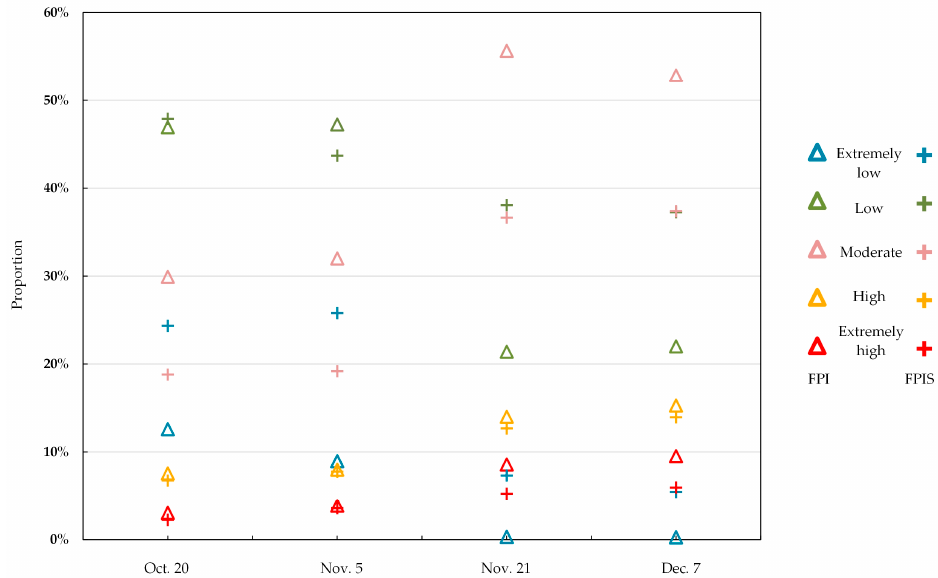
Figure 6. The dynamic changes of forest fire risk in Zhaoqing, based on the FPI and FPIS